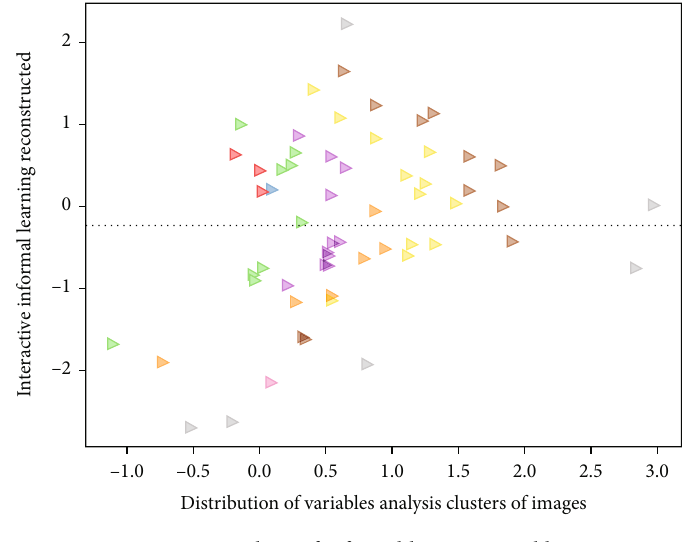
Figure 5: Analysis of informal learning variables.